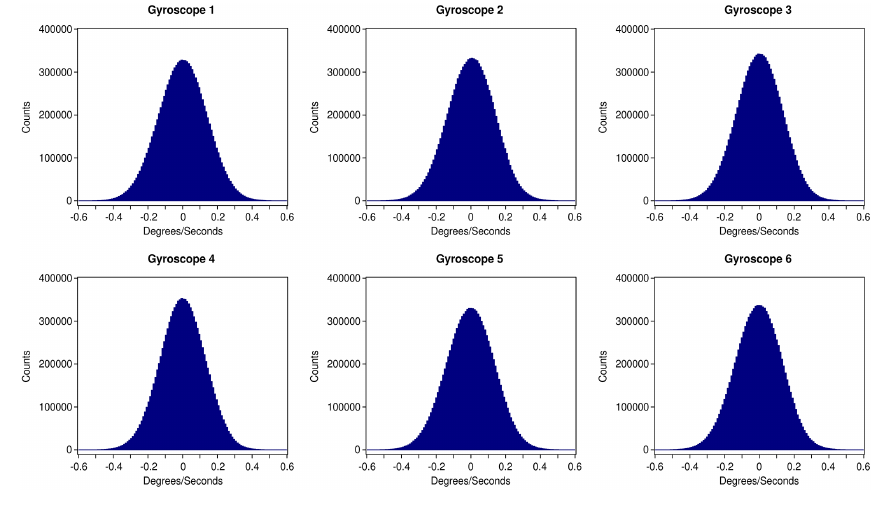
Figure 4. Angular rate histograms of the signals of Fig. 3.